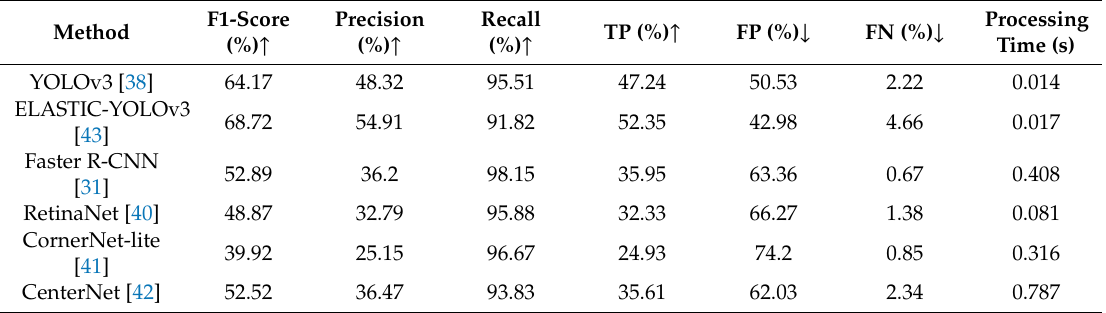
Table 2. Comparison of state-of-the-art methods for the object detection: YOLOv3, ELASTIC-YOLOv3, Faster R-CNN, RetinaNet, ConrnerNet-lite, and